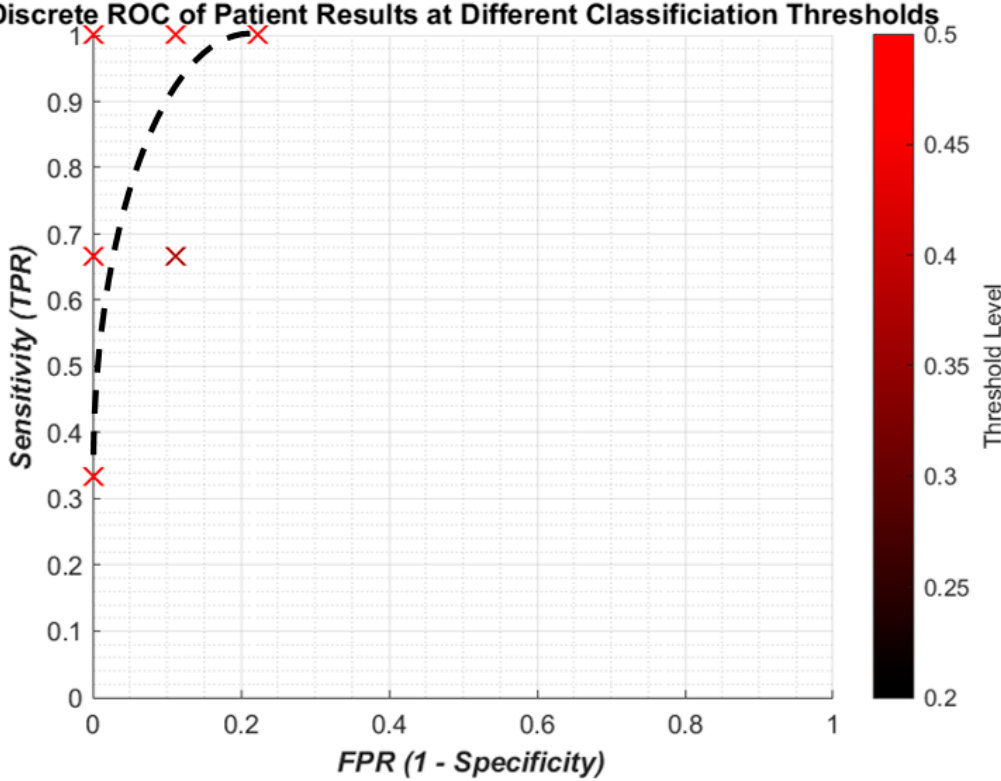
Figure 10. Discrete ROC of patient results showing clustering in North West quadrant, implying a high sensitivity with a high specificity. Dashed black line are suggested curves, not from regression.